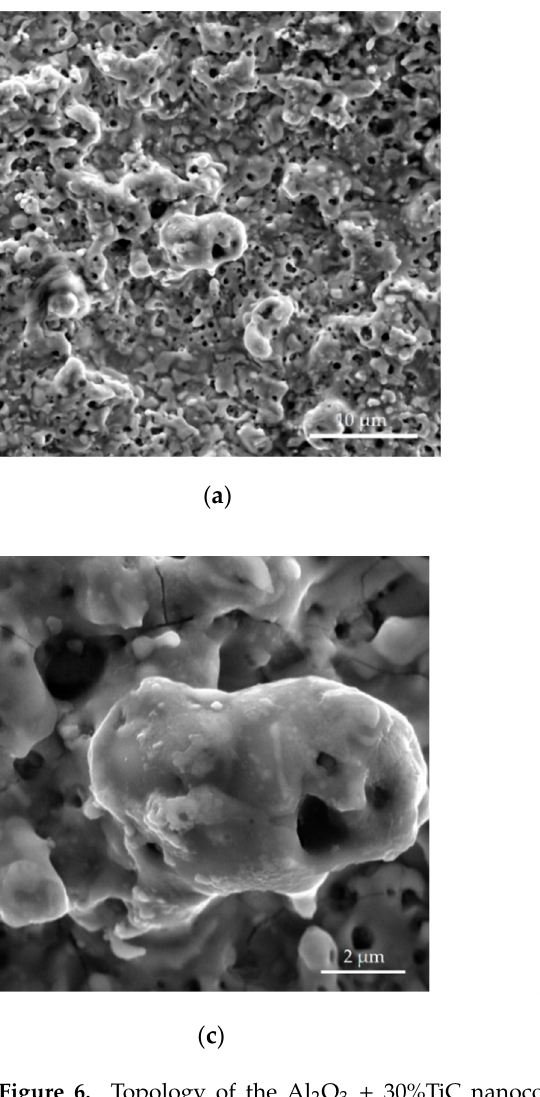
Figure 6. Topology of the Al 2 O 3 + 30%TiC nanocomposite machined surface: ( a ) oil, 10.0 k×; ( b ) water, 10.0 k×; ( c ) oil, 40.0 k×; ( d ) water, 40.0 k×.